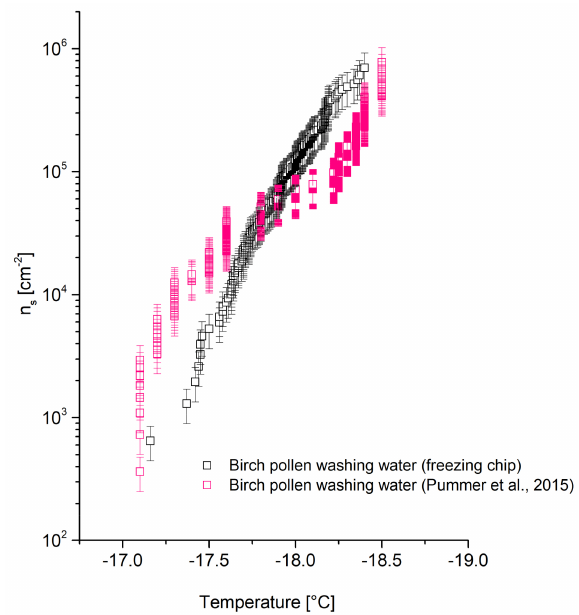
Figure 6. The n s values of birch pollen washing water determined with the freezing chip method compared with already published data [27]. The error bars of the n s values originate from the estimation of the corresponding droplet diameter of 40 µ m ± 10% and weighing uncertainties.